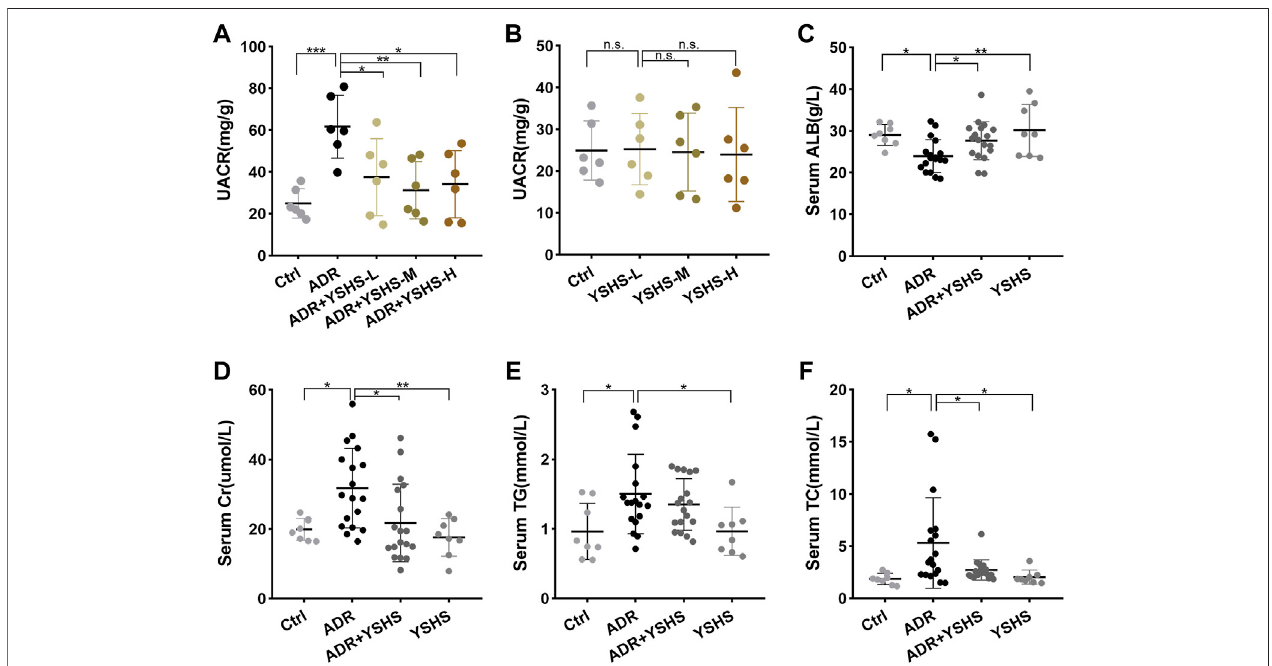
FIGURE 1 | YSHS granule mitigates kidney injury and proteinuria in ADR-induced nephropathy. (A) At the end of the fourth week of intragastric administration, 12 h-urinesampleswerecollected.TheUACR(mg/g) wasevaluatedfrommice inCtrl,ADR, andADR withthreedifferentconcentrationsofYSHStreatmentgroups. (B) Three different doses of YSHS did not cause signi fi cant changes in UACR in healthy mice. (C – F) Serum albumin (ALB) (C) , creatinine (Cr) (D) , triglyceride (TG) (E) , and total cholesterol(TC) (F) wereevaluatedin themice oftheindicated groups. The datarepresentmean ±SD, one-wayANOVA analysisfollowed by Tukeypost-hoc tests as appropriate for multiple comparisons. * p < 0.05, ** p < 0.01, *** p < 0.001, n. s., no signi fi